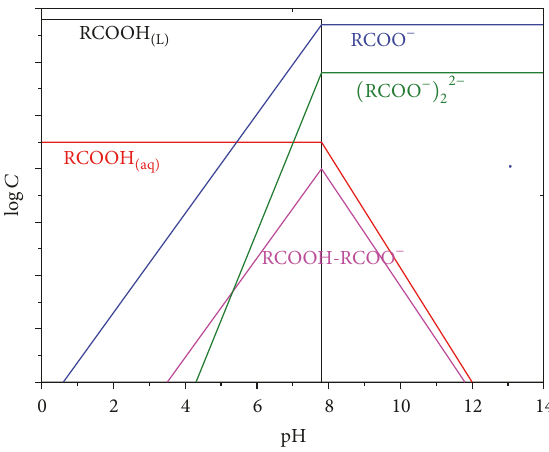
Figure 9: Distribution of sodium oleic acid in aqueous